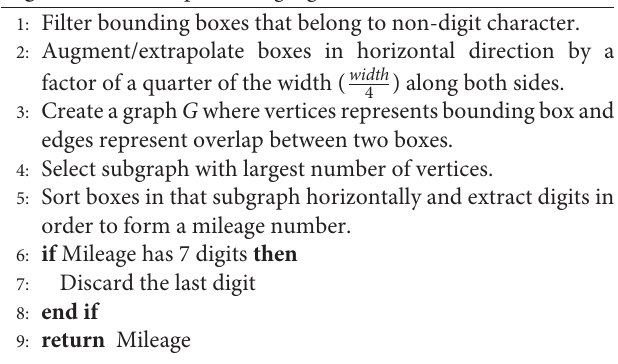
Algorithm 1: Post-processing